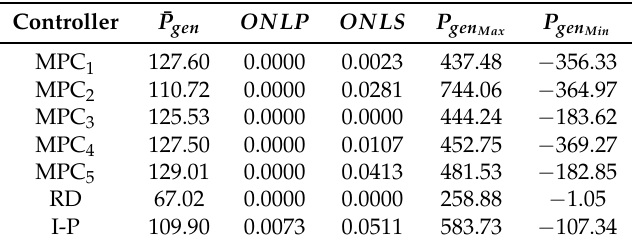
Table 5. Results obtained in the application of the seven controllers to the WEC system. The powers are expressed in kW. Note that ONLP indicates overshoot of nominal limits for position and ONLS indicates overshoot of nominal limits for speed.